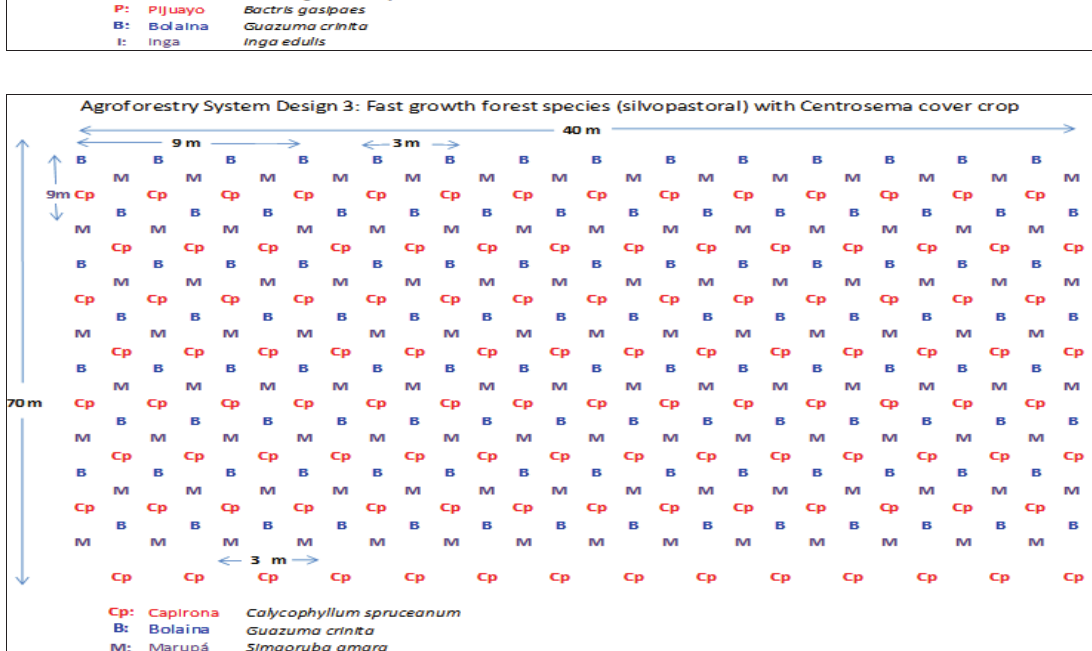
Figure 2. Prototype of three agroforestry systems of different tree species in Santo Tomas,